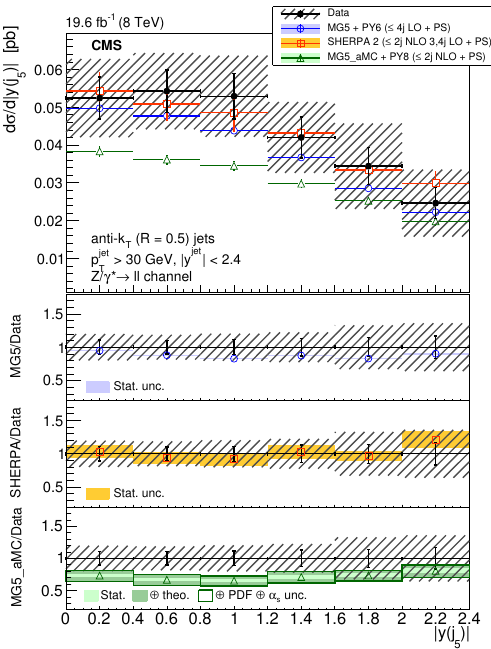
Figure 8 . The di(cid:11)erential cross section for Z ( ! ‘‘ ) + jets production measured as a function of the 5 th jet j y j compared to the predictions calculated with MadGraph 5 + pythia 6, sherpa 2, and mg5 a mc + pythia 8. The lower panels show the ratios of the theoretical predictions to the measurements. Error bars around the experimental points show the statistical uncertainty, while the cross-hatched bands indicate the statistical and systematic uncertainties added in quadrature. The boxes around the mg5 a mc + pythia 8 to measurement ratio represent the uncertainty on the prediction, including statistical, theoretical (from scale variations), and PDF uncertainties. The dark green area represents the statistical and theoretical uncertainties only, while the light green area represents the statistical uncertainty